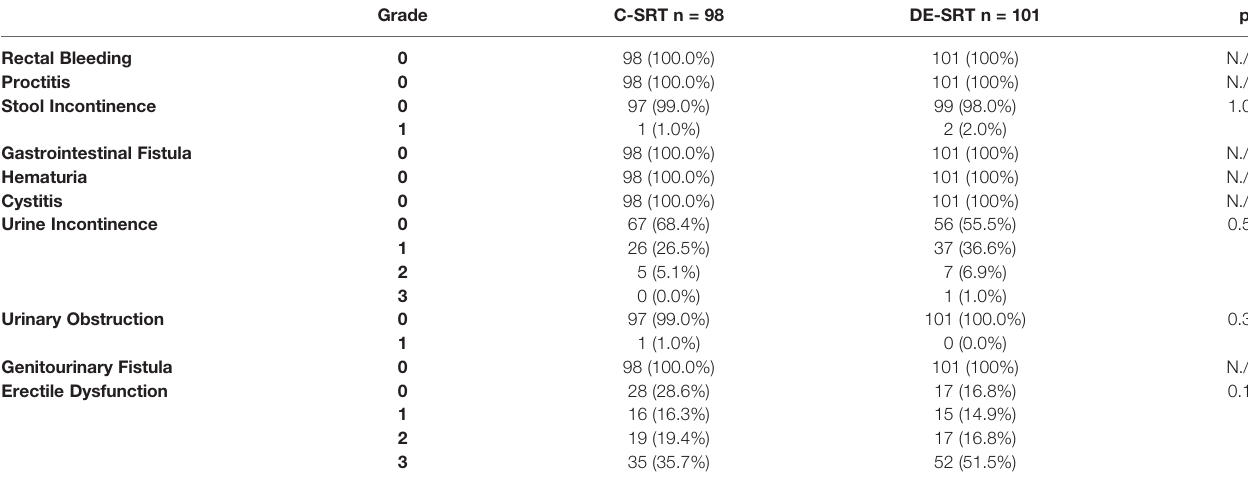
TABLE 3 | Baseline toxicity rates of conventional salvage radiotherapy (C-SRT) and dose-escalated salvage radiotherapy